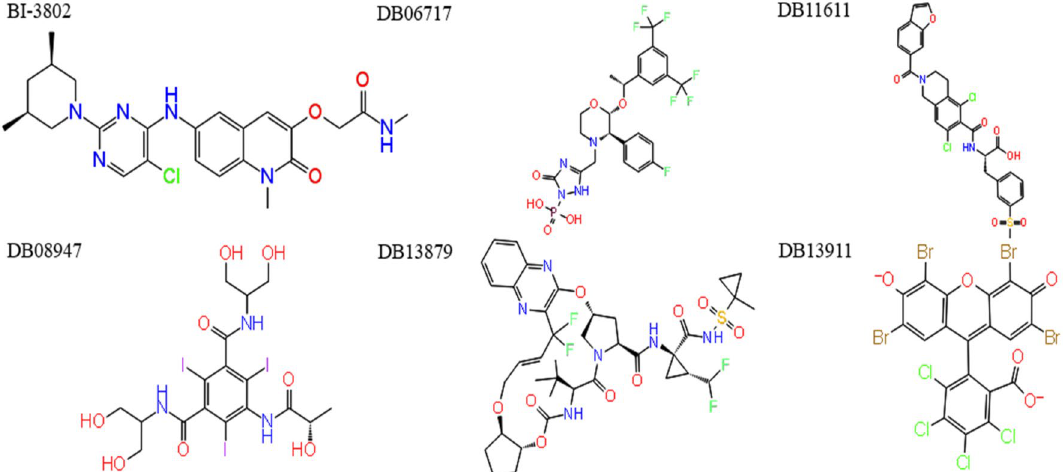
Figure 1. The 2D structure of BI-3802 and the top five results of virtual screening analyses with the highest binding